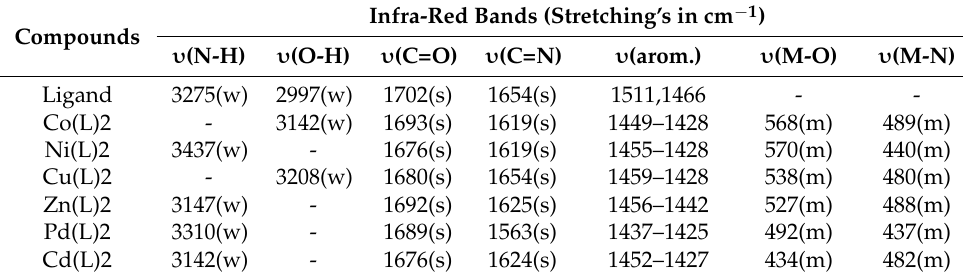
Table 1. Infra-Red absorption frequency of